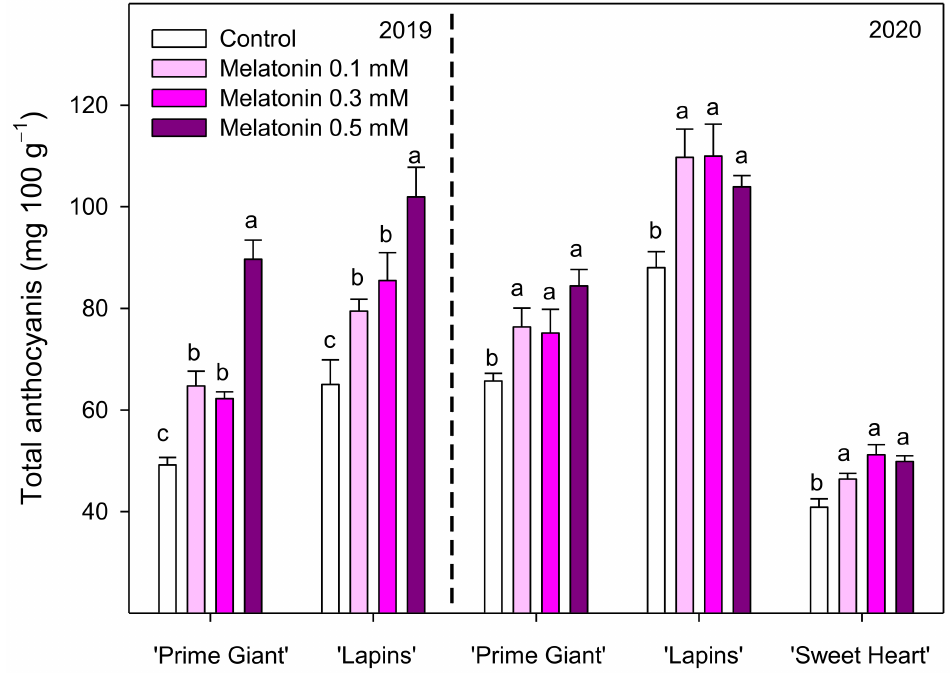
Figure 5. Total anthocyanin concentration in sweet cherries from control and melatonin-treated trees in the 2019 and 2020 experiments. Data are the mean ± SE of determinations made in duplicate in three replicates. Different letters show significant differences ( p < 0.05) between treatments for each cultivar and